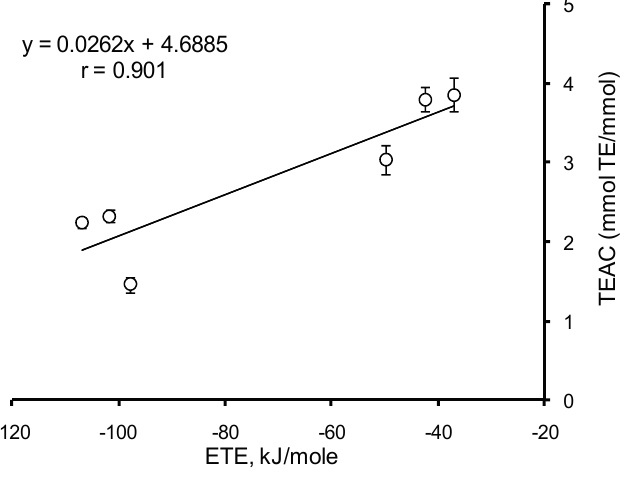
Figure 11. Correlation analysis of HB/HC acid AOC against the ABTS cation radical at pH 7.4 versus values of electron transfer enthalpy (ETE) from phenolate ion.